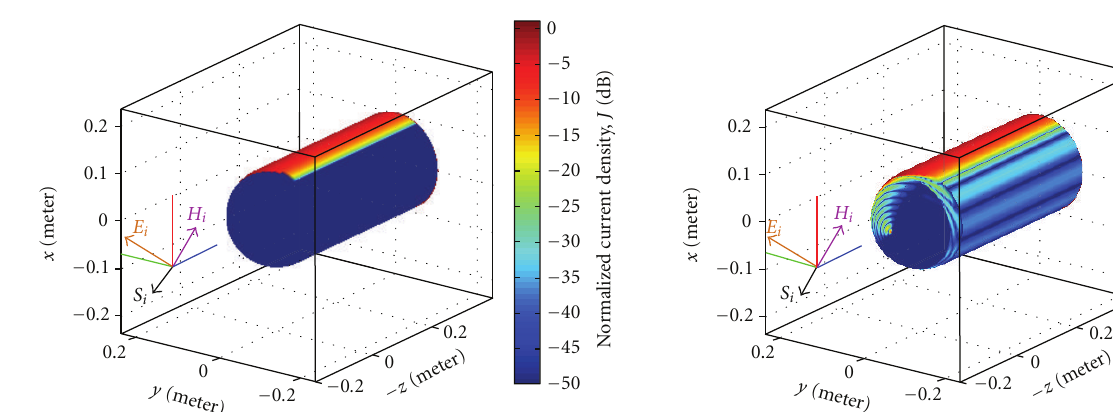
Figure 4: Surface current density using PO method for an incident field θ = 20 ◦ , φ = 60 ◦ .